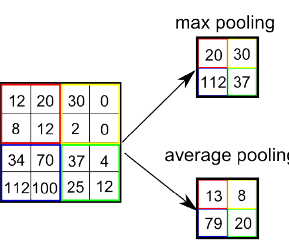
Figure 2. Pooling operation.